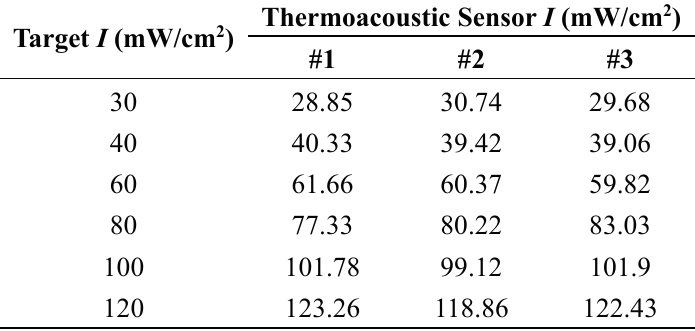
Table 5. Measurement results of the new sensor